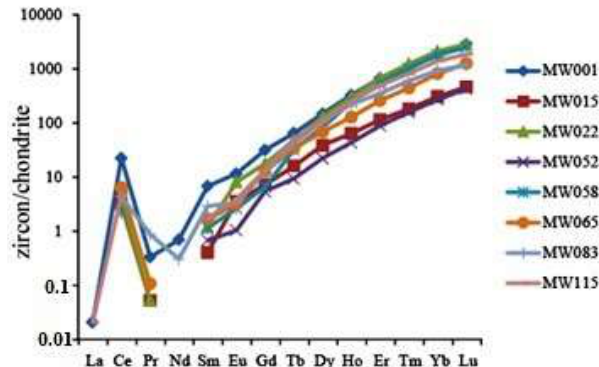
Figure 3. The western Meiganga magmatic zircon grains are normalized to [59] chondrite values and are plotted on Log 10 versus element (La–Lu) diagrams.